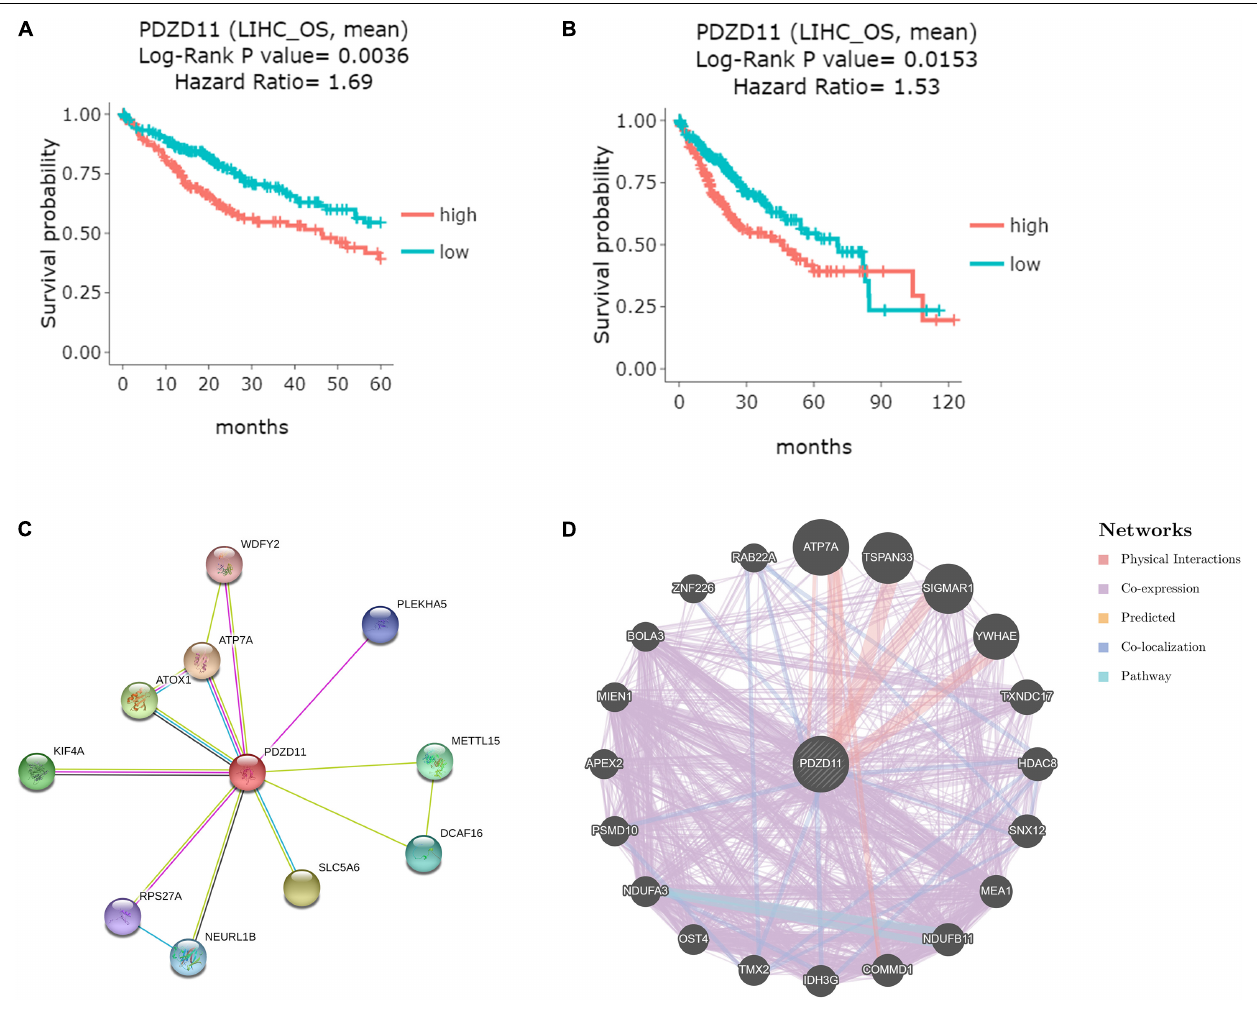
FIGURE 4 | Visual summary of the prognostic value and biological interaction network of PDZD11 in LIHC. (A,B) Kaplan-Meier plot of the relationship of PDZD11 gene expression and survival in LIHC patients (DriverDBV3 database). The LIHC patient samples are stratified into 2 groups using the mean expression value as the cut-off point: 149 samples with highly expressed PDZD11 mRNA (red) and 216 samples with lowly expressed PDZD11 mRNA (green). Y -axis is survival probability. The left figure is the 5-year survival, and the right figure shows overall survival (OS). The X -axis is the months of survival period. Log-Rank P -value and Hazard Ration (HR) are provided on the top of plots. (C) Protein-protein interaction (PPI) network of PDZD11 (Top 10) (STRING database). (D) PPI network (Top 20) of PDZD11 from GeneMANIA database.